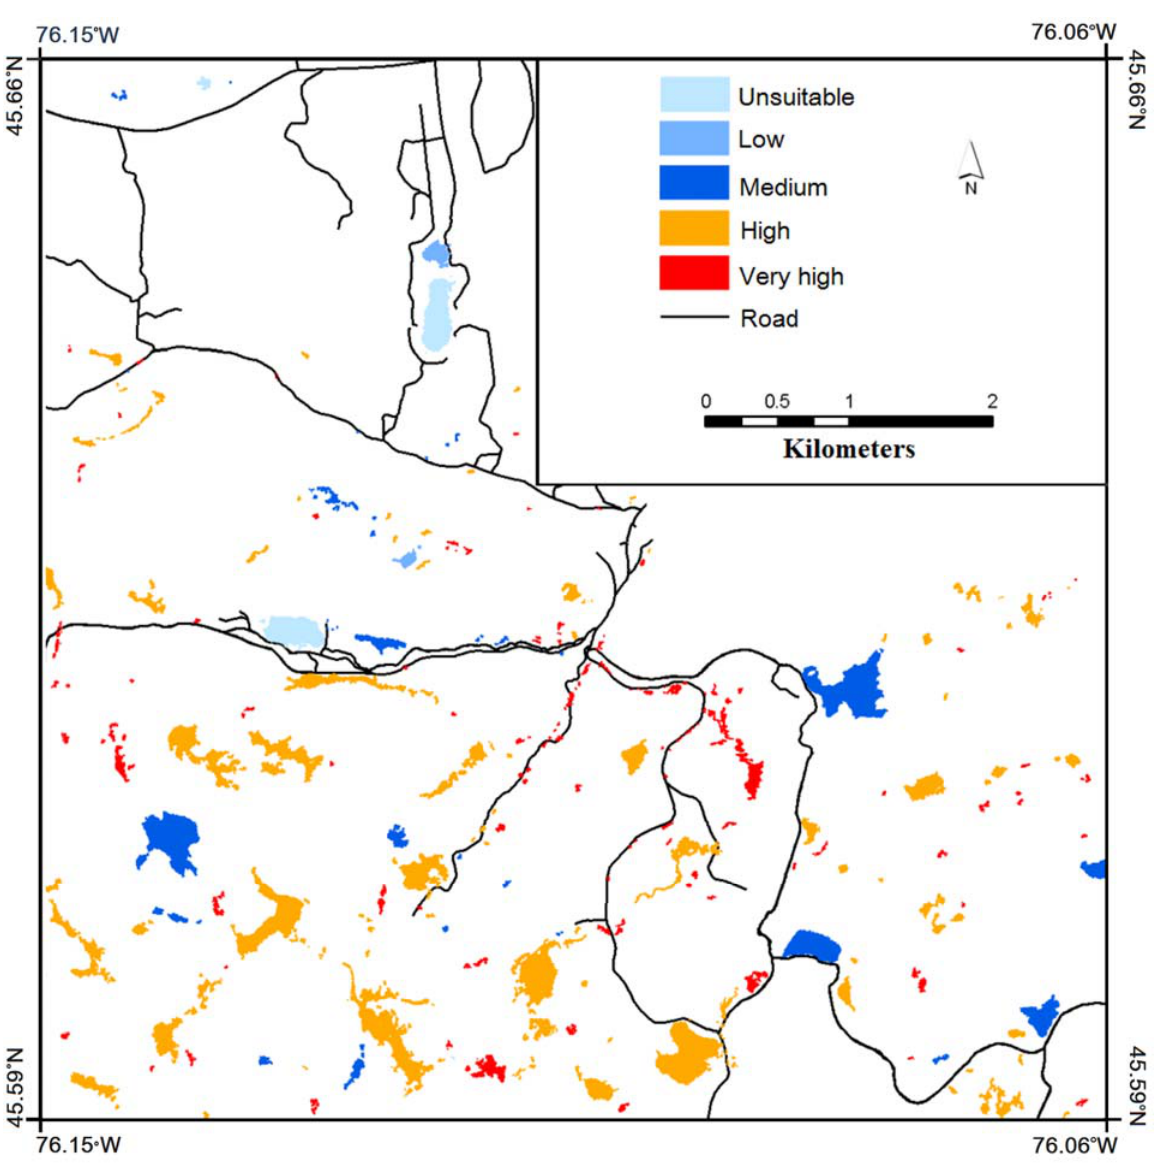
Figure 9. Example of a portion of the Blanding’s turtle habitat suitability map for the study area that was derived from an additive scoring system for wetlands, and the presence and abundance of wetland vegetation, and logs (Road source: